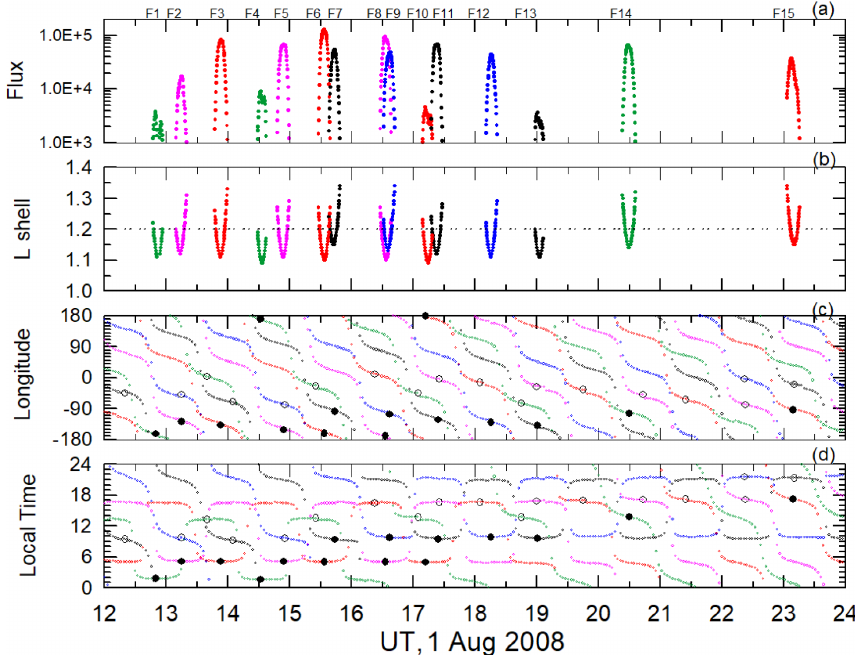
Figure 2. FEE enhancements on 1 August 2008: (a) fluxes of > 30keV electrons in units (cm 2 ssr) − 1 , (b) L shell of enhancements, (c) longitude, and (d) local time of peak fluxes (black circles). Measurements within the SAA area are indicated by the open circles. Colourful curves denote NOAA/POES satellites: P2 (black), P5 (pink), P6 (red), P7 (blue), and P8 (green). The horizontal dashed line in panel (b) depicts the lower edge of the inner radiation belt. FEE enhancements peak at the equator (minimal L shells), which indicates a fast radial transport from the inner radiation